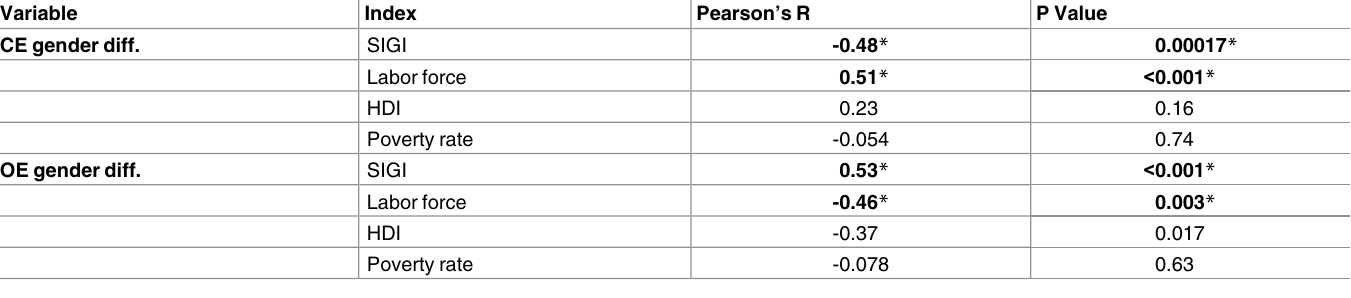
Note . * indicates significance after Bonferroni correction (cutoff =